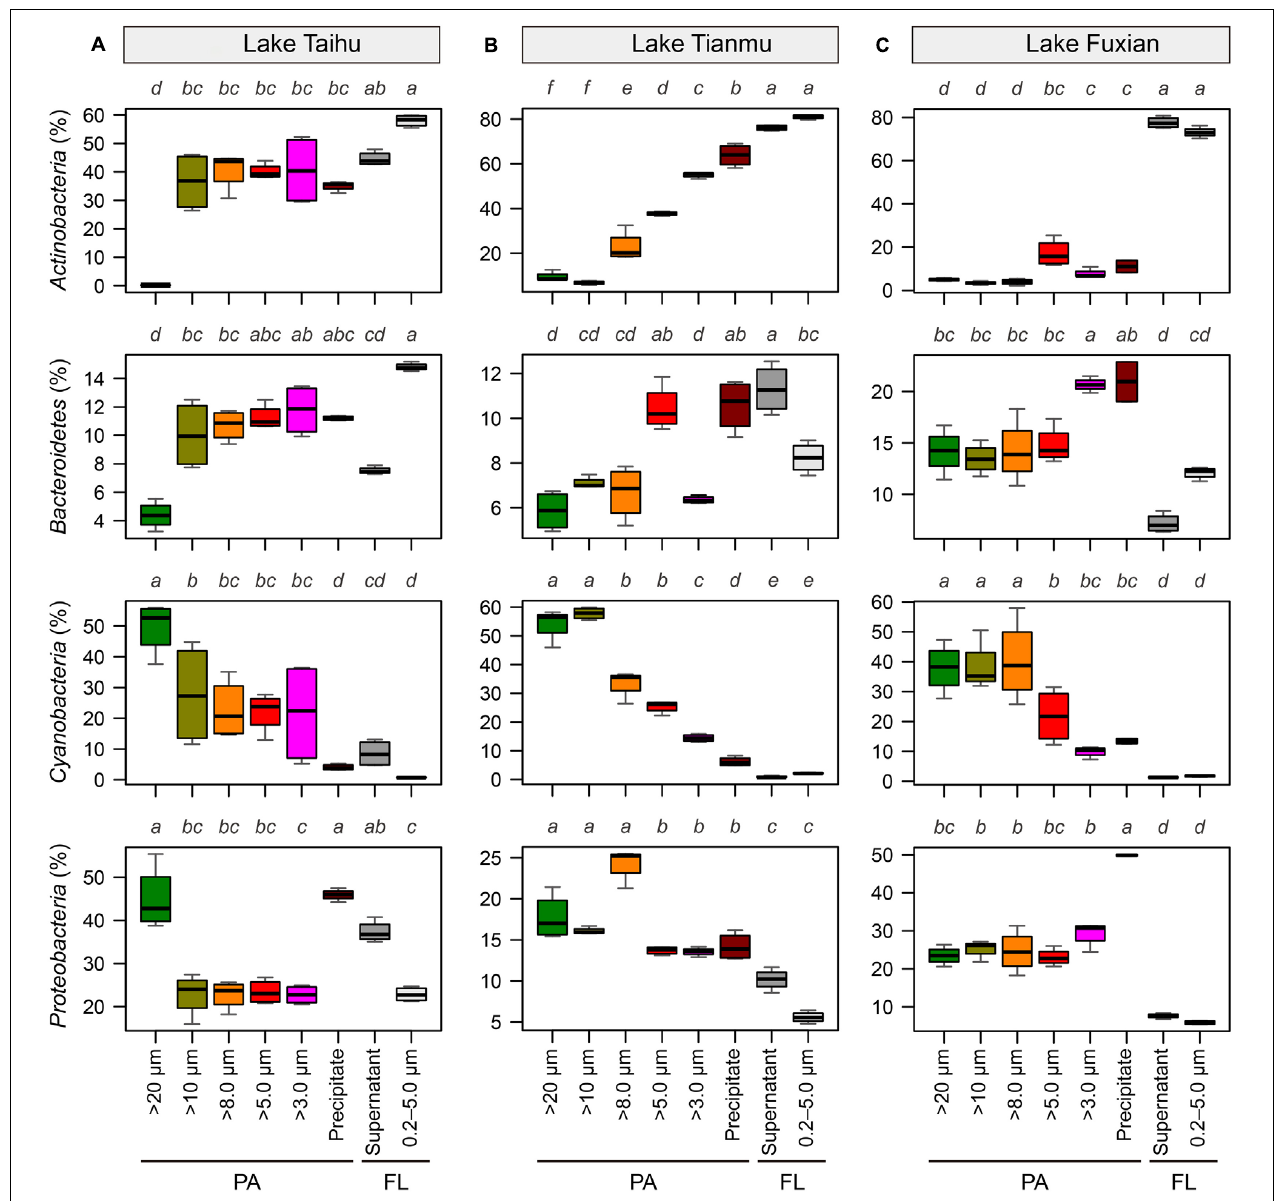
FIGURE 6 | Boxplots of the major four bacterial phyla for each sample collection treatment in (A) Lake Taihu, (B) Lake Tianmu, and (C) Lake Fuxian. Note variation in y -axis scales in different lakes. To examine the differences between treatments, the Kruskal–Wallis test was performed with Holm correction of P -values for multiple comparisons. Different lower-case letters above each boxplot indicate significant differences ( P < 0.05) among treatments. PA, particle-attached; FL,